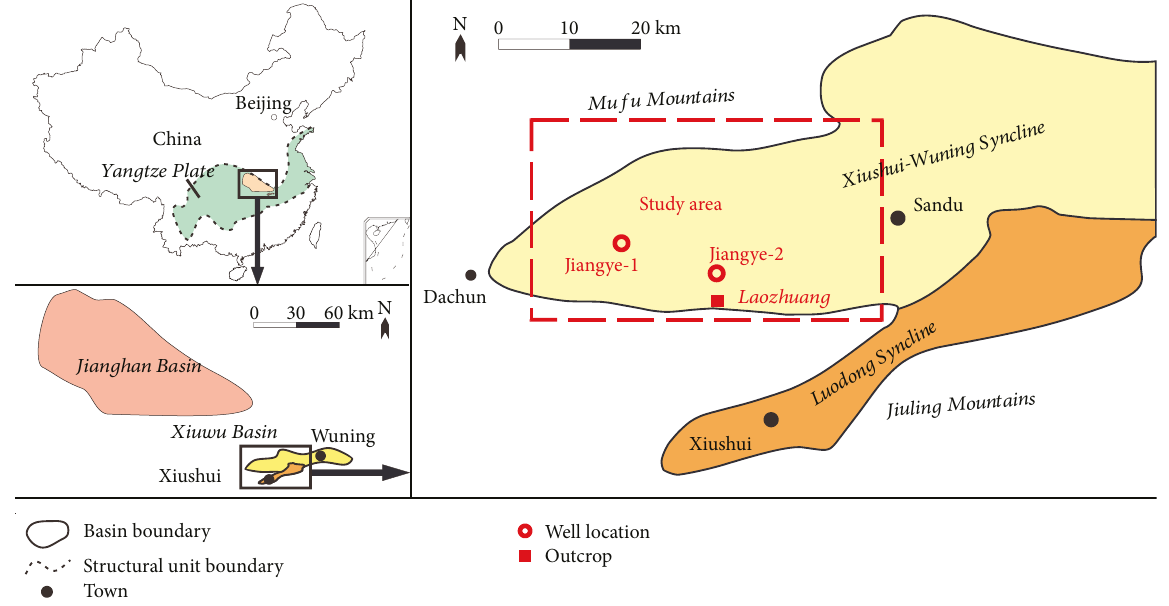
Figure 1: Locations of the study area and wells and outcrop